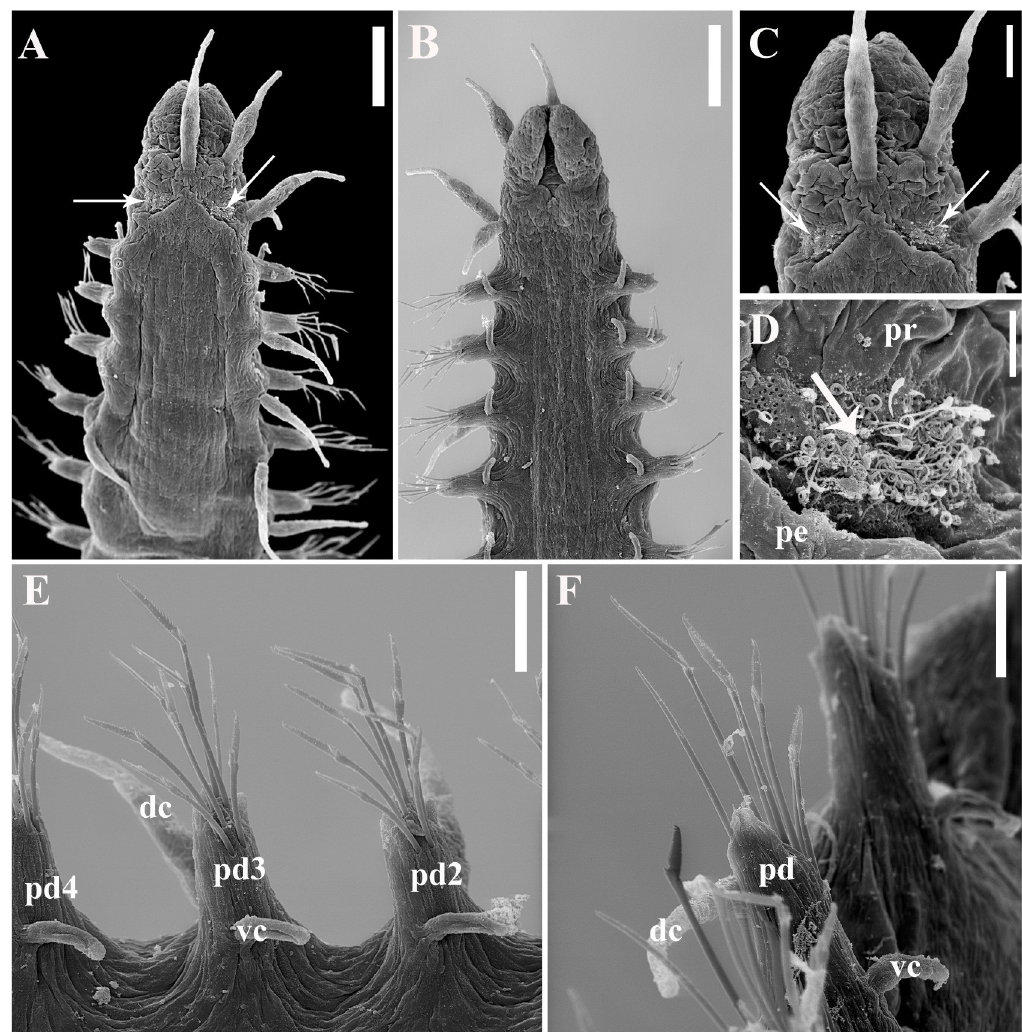
Fig 3. Salvatoria nitiduloides n. sp., SEM. (A, B). Anterior body, dorsal and ventral views, respectively; (C). Close up view of the anterior end, dorsal view; (D). Detail of ciliated nuchal organ; (E). Parapodia 2–4, ventral view; (F). Posterior parapodia, ventro-lateral view. Arrows pointing to ciliated nuchal organs; dc –dorsal cirrus; pd –parapodial lobe; pd2, pd3, pd4 –parapodial lobes of chaetigers 2, 3 and 4 respectively; pe –peristomium; pr –prostomium; vc –ventral cirrus. Scale bars: A–B, 50 μ m; C, E–F, 20 μ m; D, 5 μ